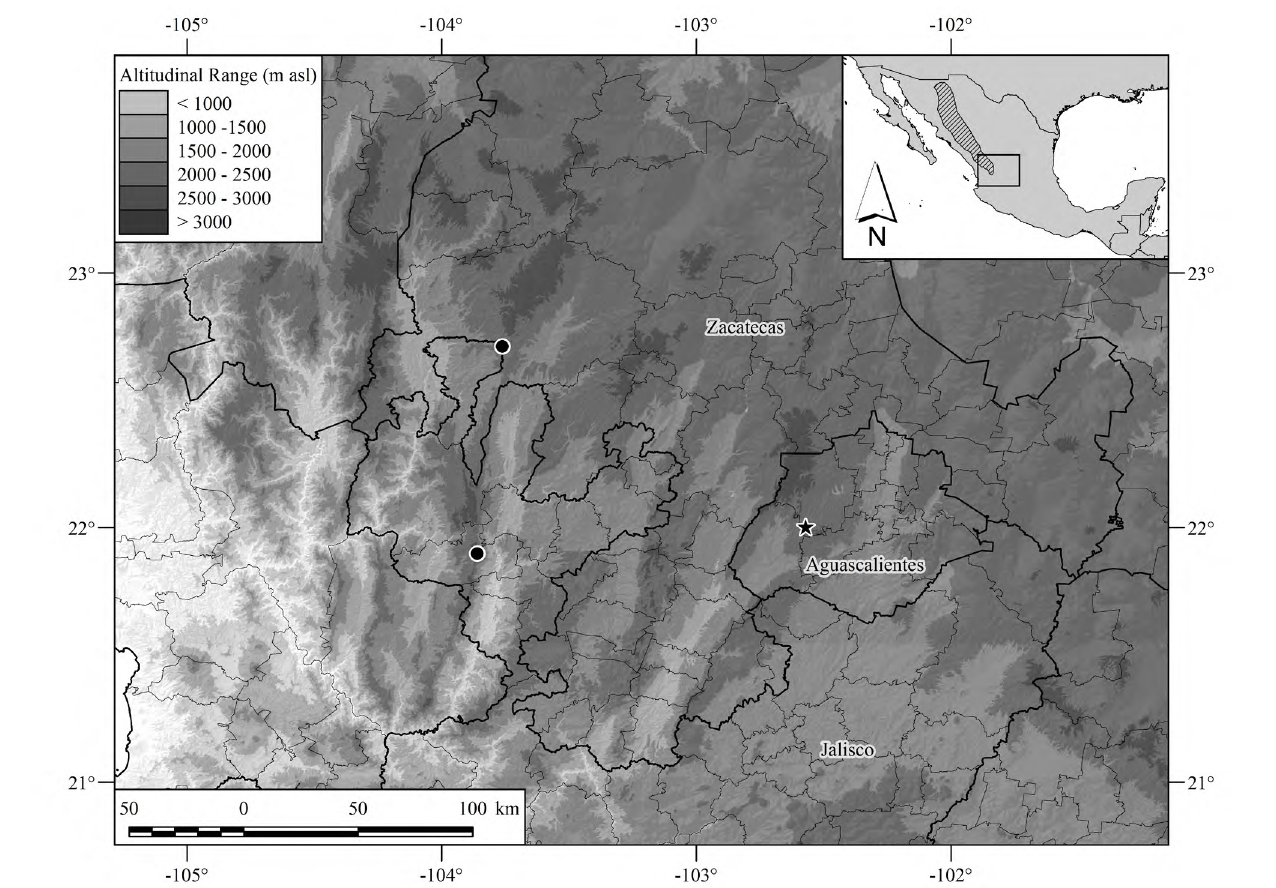
Figure 2. Collecting localities for Ambystoma rosaceum across its southeastern geographic range in México; star represent new record of Ambystoma rosaceum for Aguascalientes at Mesa Montoro, San José de Gracia, and black circles nearest recorded localities at Bolaños, Jalisco and Valparaiso, Zacate- cas. The hatched area represents the IUCN Red List of Threatened Species distribution of A. rosaceum (Shaffer et al.